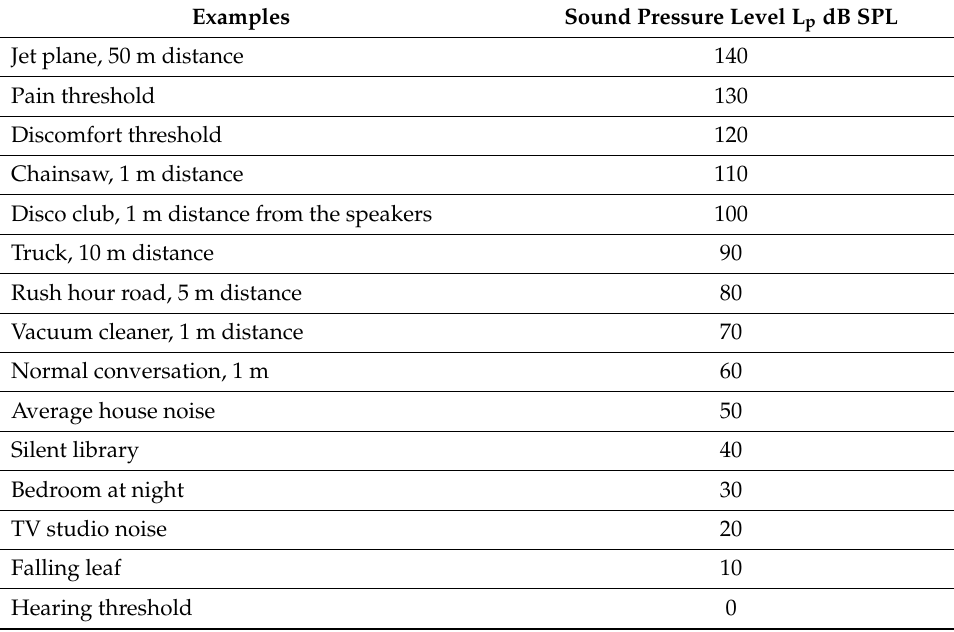
Table A1. Display of decibel level comparison [38].